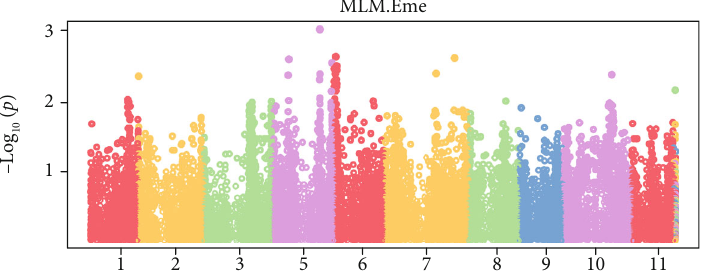
Figure 1: The Manhattan plot for total Striga plants emerged shows that there are three SNP markers at chromosomes 5, 6, and 7 considering a LOD score of